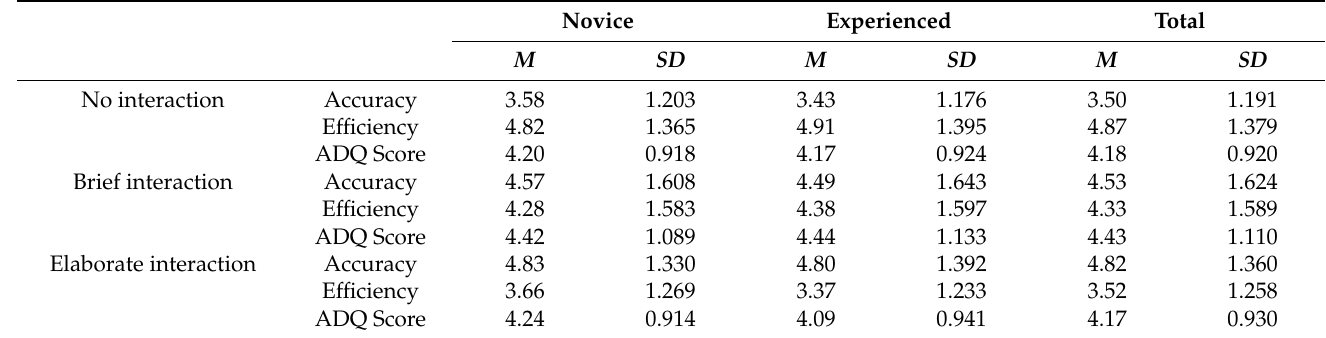
Table 1. Mean scores for accuracy and efficiency ratings and the ADQ scores. Novice Experienced Total M SD M